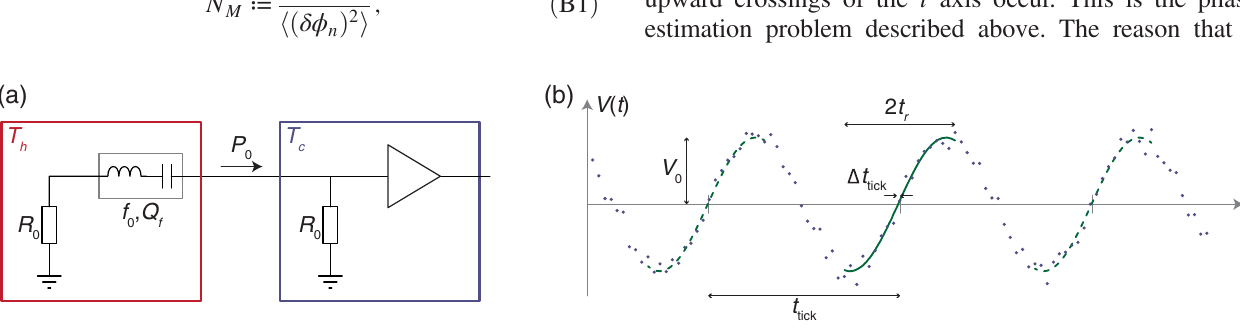
FIG. 5. Simple electrothermal clock. (a) The setup. The Johnson noise of resistor R 0 , in equilibrium with a hot bath at temperature T , h is filtered to pass frequency f 0 with bandwidth f 0 =Q . The resulting signal, whose power is P 0 , is passed to a matched resistor and f amplifier at temperature T . (b) From the noisy voltage record (points) seen by the amplifier, we can generate clock ticks by estimating c 1 =f the zero crossing of each cycle using a sinusoidal fit (lines). Here Δ t marks the sampling interval, t 0 is the average tick interval, tick ¼ (cid:2) t r is the fit range, and Δ t tick is the fit